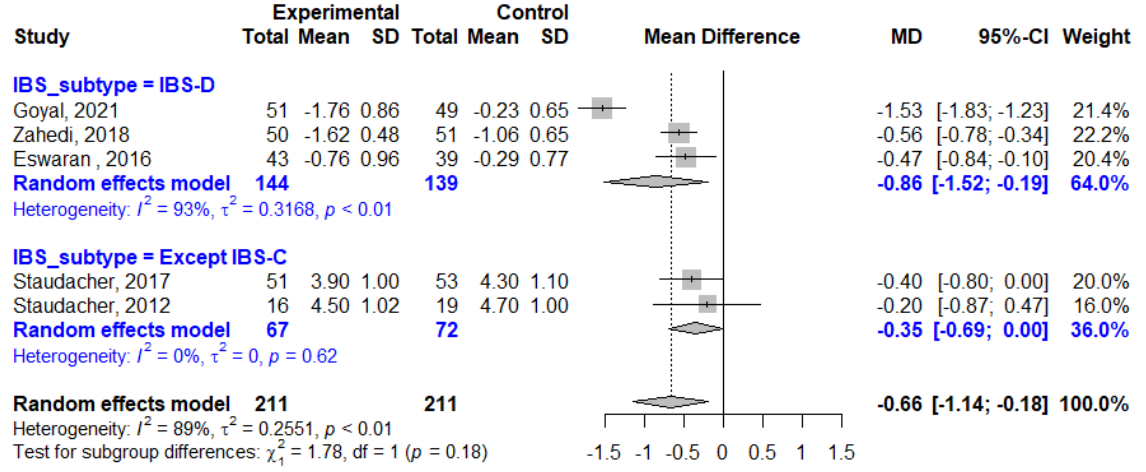
Figure 8. Forest plot showing mean differences in BSFS. SD, standard deviation; MD, mean difference; CI, confidence interval.